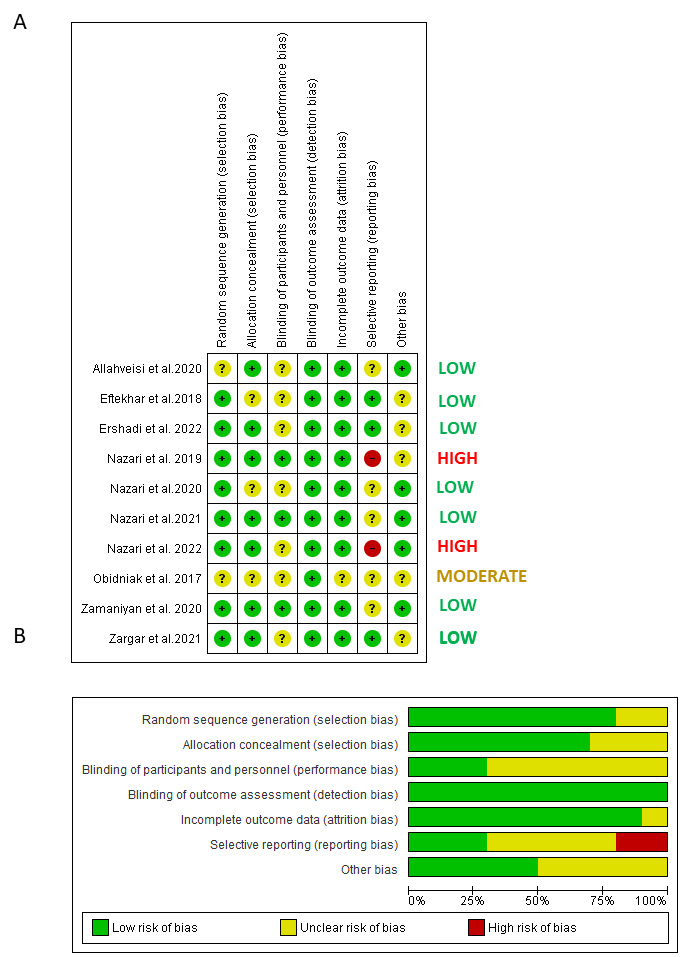
Figure 2. Quality assessment of the included RCTs. ( A ) Risk of bias summary: review authors’ judgments about each risk of bias item for each included study: (+), low risk of bias; ( − ): high risk of bias; (?): unclear risk of bias. ( B ) Risk of bias graph: review authors’ judgments about each risk of bias item presented as percentages across all included studies.